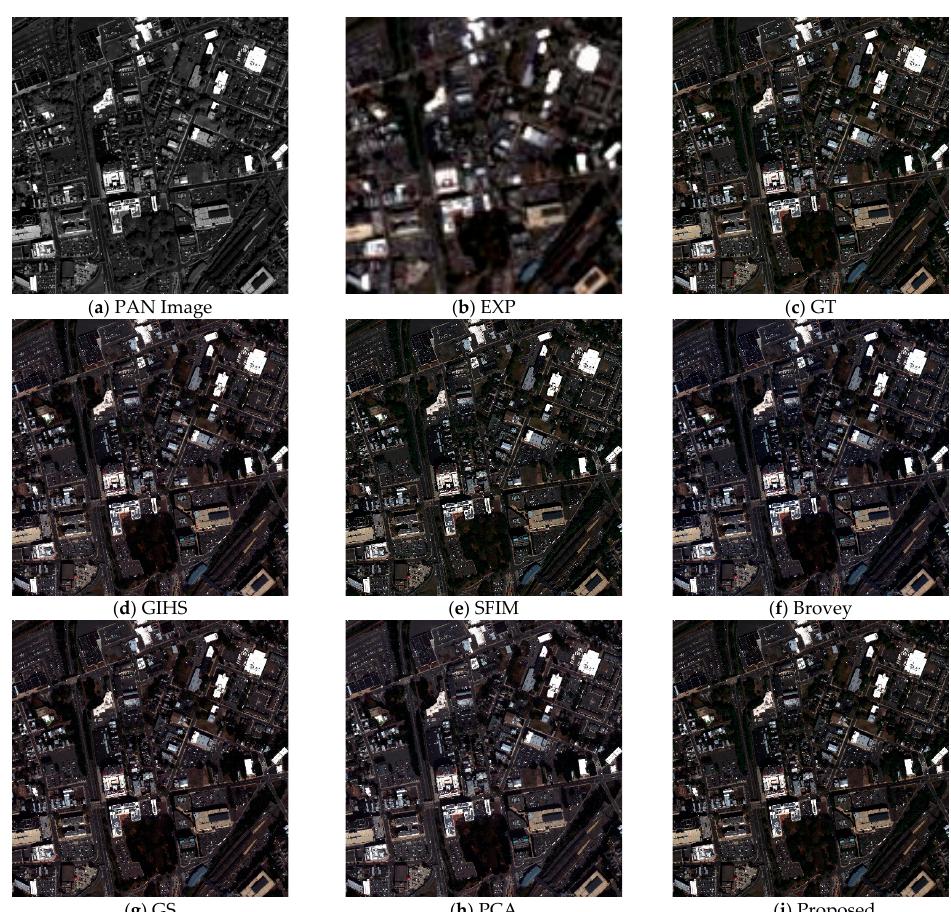
Figure 4. Fusion results for GE-1 images using different methods. Table 2. Objective assessment indexes of the GE-1 image fusion results.